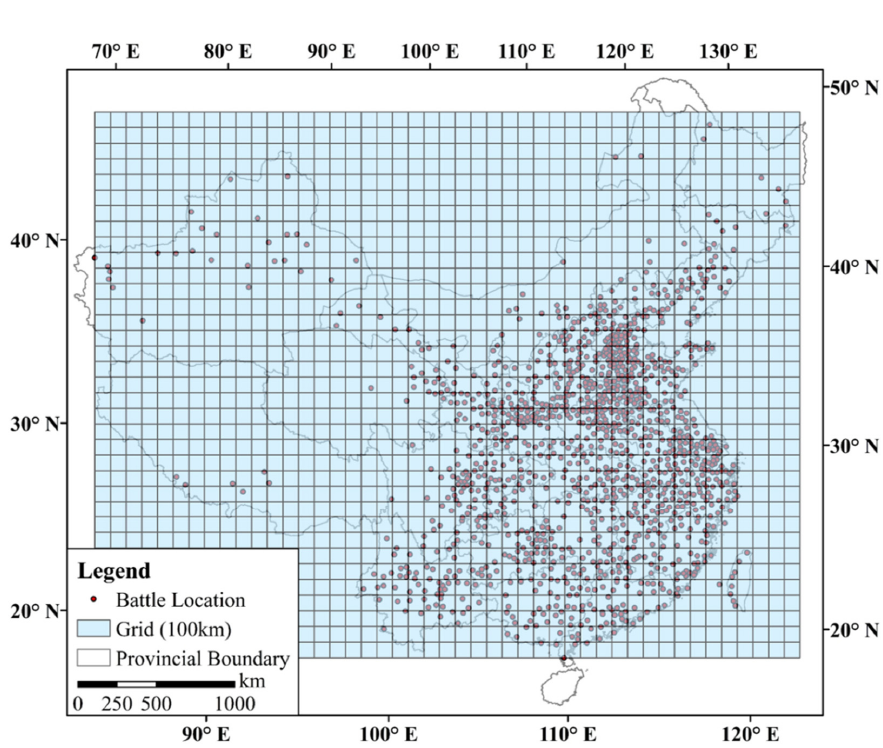
Figure 2. Battle location and the grid (100 × 100 km per cell) adopted in this study.